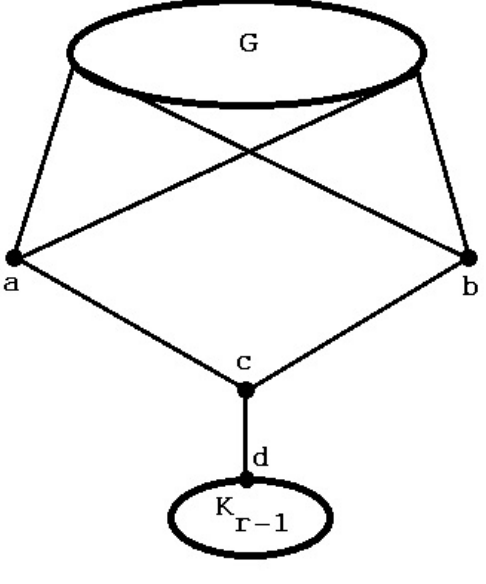
Figure 1. G r for a given graph G